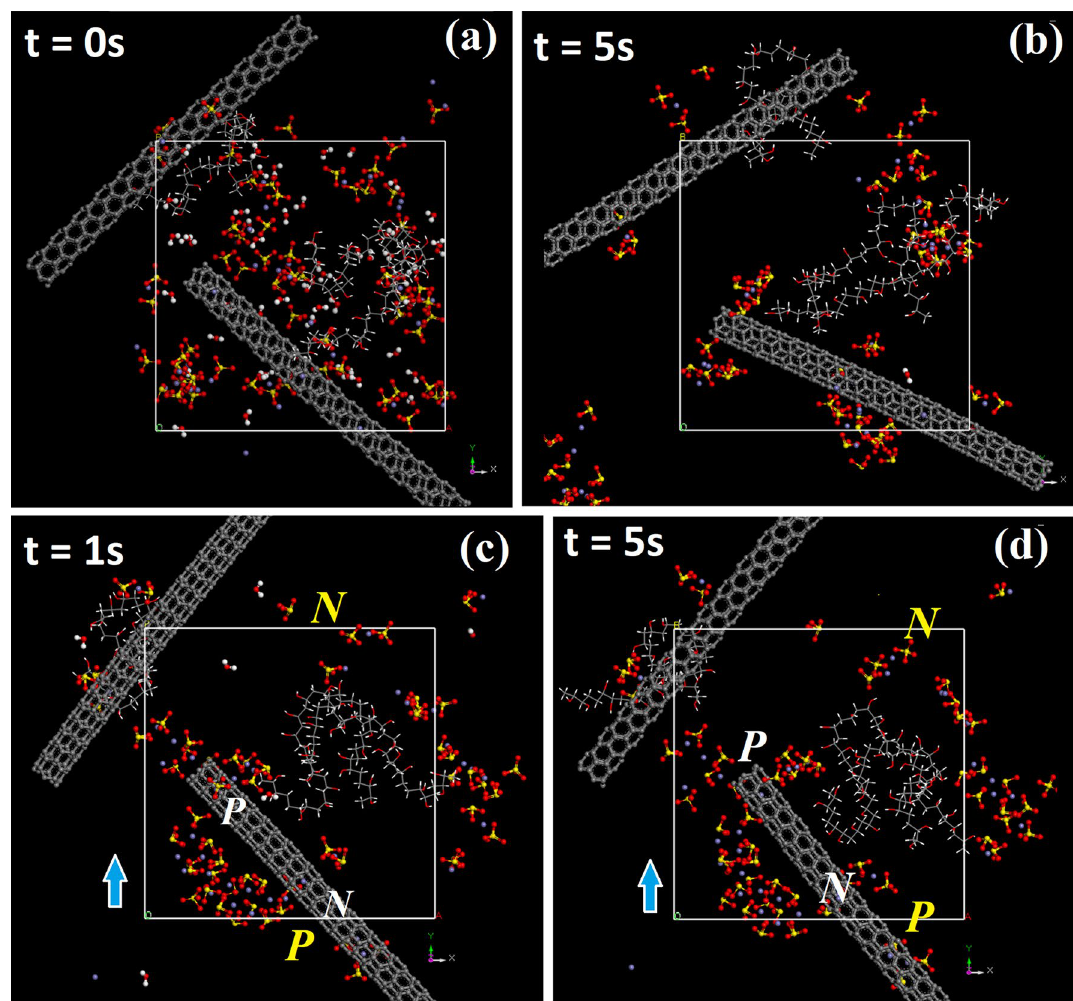
Figure 6. Snapshots extracted from geometric optimization of complex-III at E = 0 and t = 0 s ( a ) and 5 s ( b ) and at E = 600 V/cm and t = 1 s ( c ) and 5 s ( d ). Polarized tubes display E in opposite direction to external field ( P and N in white).